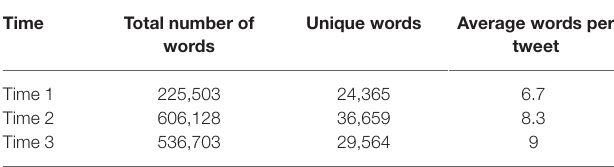
TABLE 4 | Brief statistics of words for action tweets.